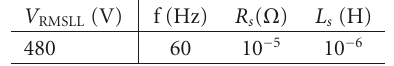
Table A.5: Parameters of source of test system 2.